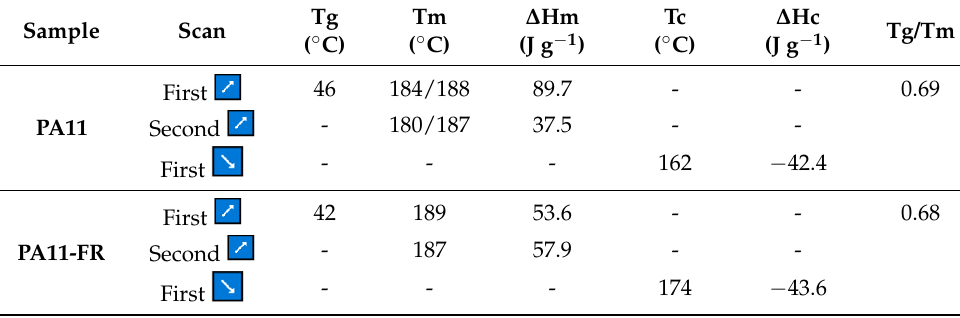
Figure 3. DSC curves of PA and PA11-FR and zoom-in the PA11-FR glass transition. Table 2. Thermal characteristics of PA11 and PA1-FR.